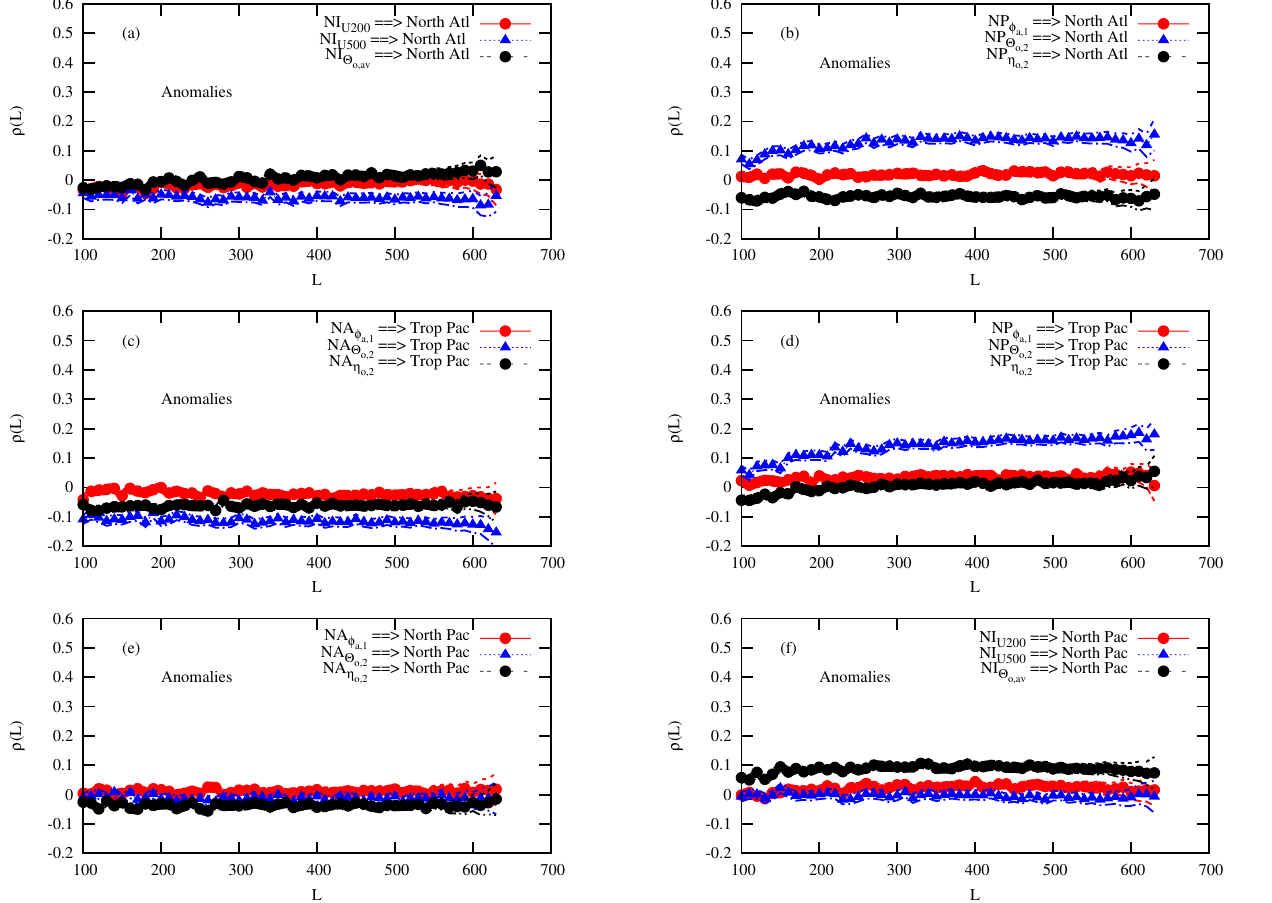
Figure C2. CCM as a function of the size L of the samples, as obtained from the anomaly of the monthly time series displayed in Fig. 2 for the ERA-20C and ORAS4 reanalyses. Each line with symbols corresponds to the influence of one variable on a specific coupled ocean– atmosphere basin. The specific variables are denoted in the caption corresponding to each line in each